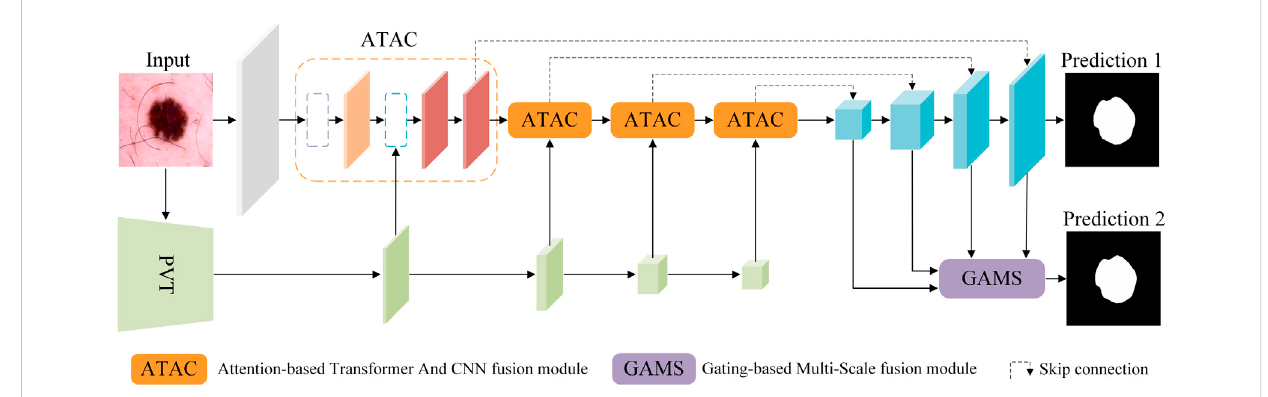
FIGURE 2 The pipeline of the proposed method. Building on the U-Net and incorporating both CNN and Transformer, it includes two new fusion modules, ATAC and GAMS, into the encoder and decoder respectively for progressively boosting the feature during abstraction and adaptively combining the features for classi fi cation respectively. Note: PVT stands for PVT v2, which supplies the Transformer features to ATAC.